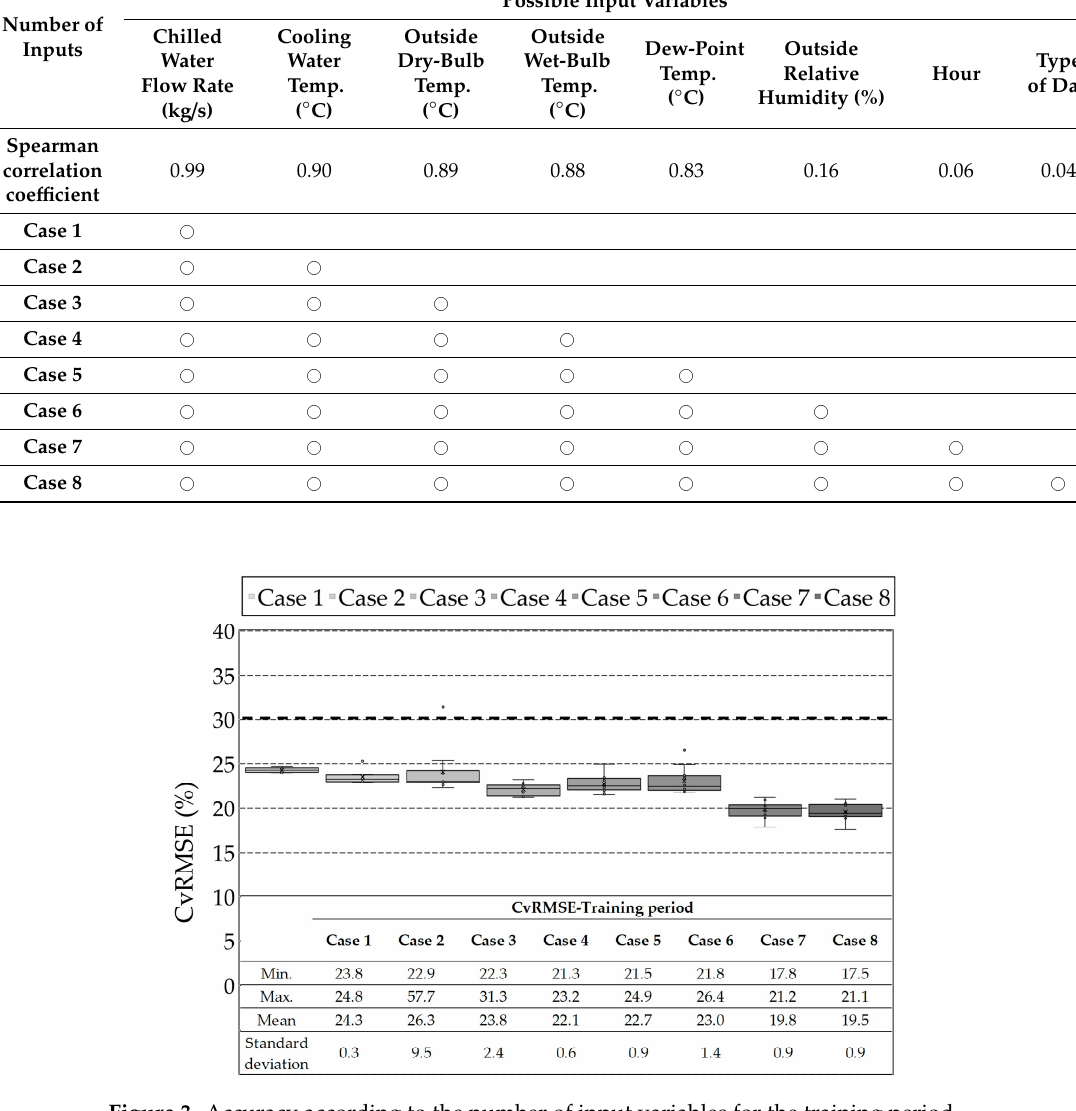
Figure 3. Accuracy according to the number of input variables for the training period.